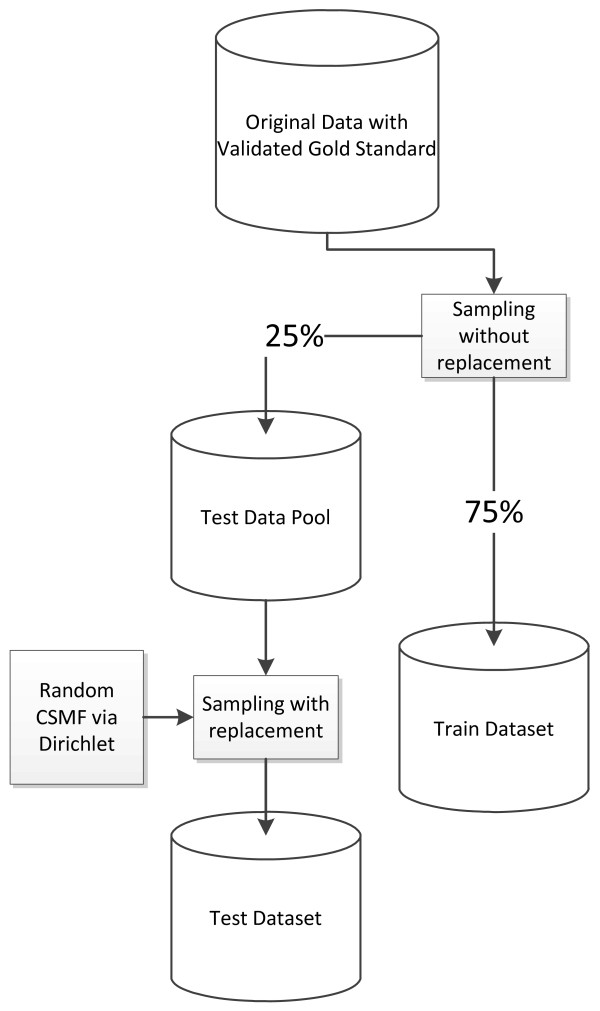
The process of generating 500 test and training datasets (done separately for each cause of death).